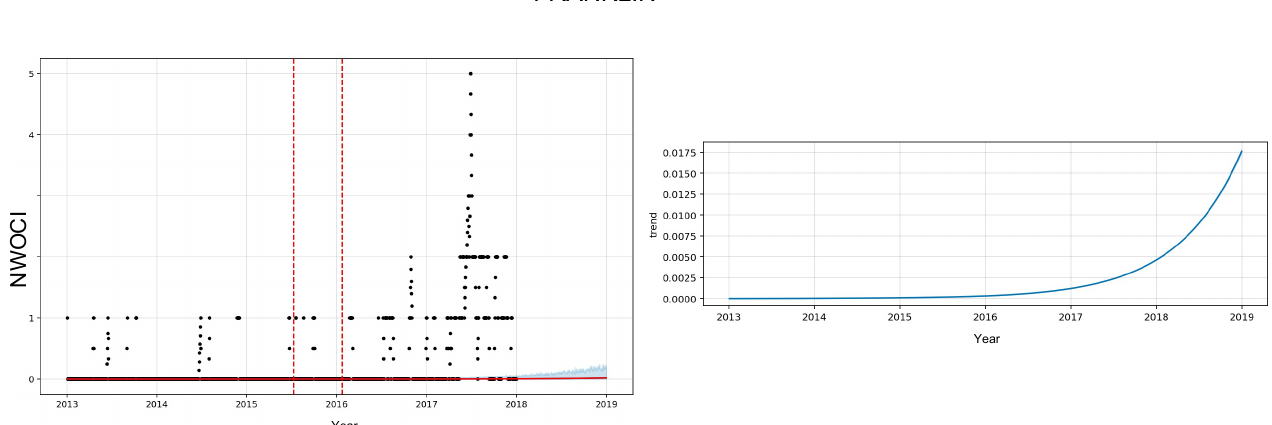
Figure A6. Left : One year forecast (2018 test data) from Prophet-BU Model for Franklin county in MA. N.B: The solid blue line shows the average forecast while the solid red line shows the observed trend of NWOCI and the light blue region represents the 80% confidence interval for the forecast uncertainty. Also, the scatter points represent the historical values in the training data (2013–2017). Right : Corresponding trend decomposition from Prophet-BU Model.